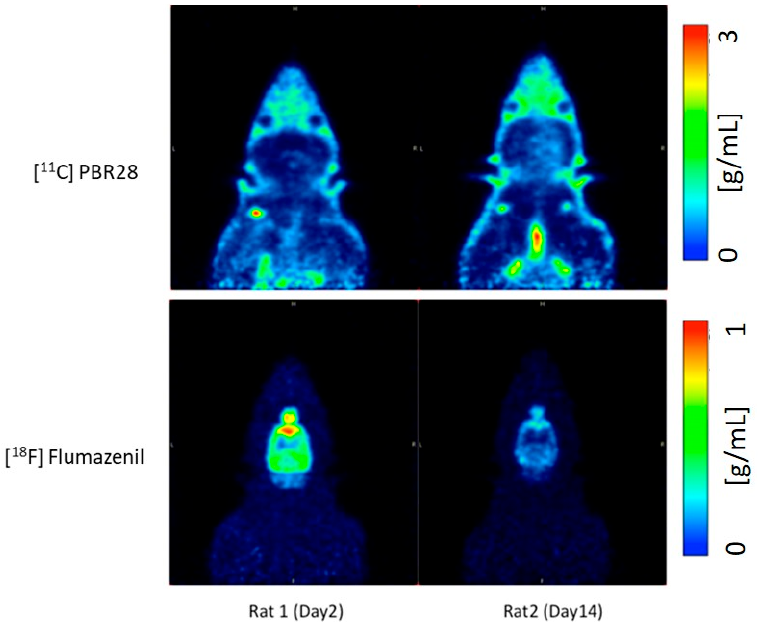
Figure 1. Illustrative PET images of Rat 1 and Rat 2 using [ 11 C]PBR28 and [ 18 F]flumazenil on day 2 and day 14 post injury.